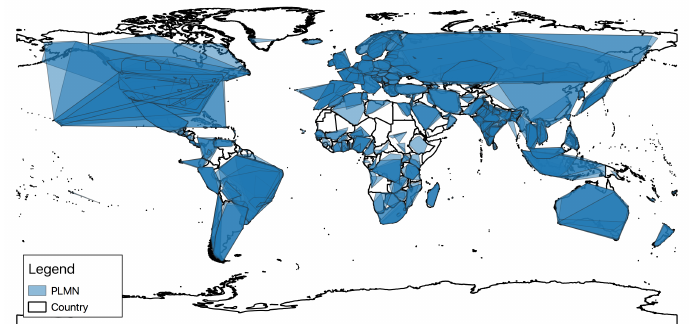
Figure 14. A general overview of PLMN